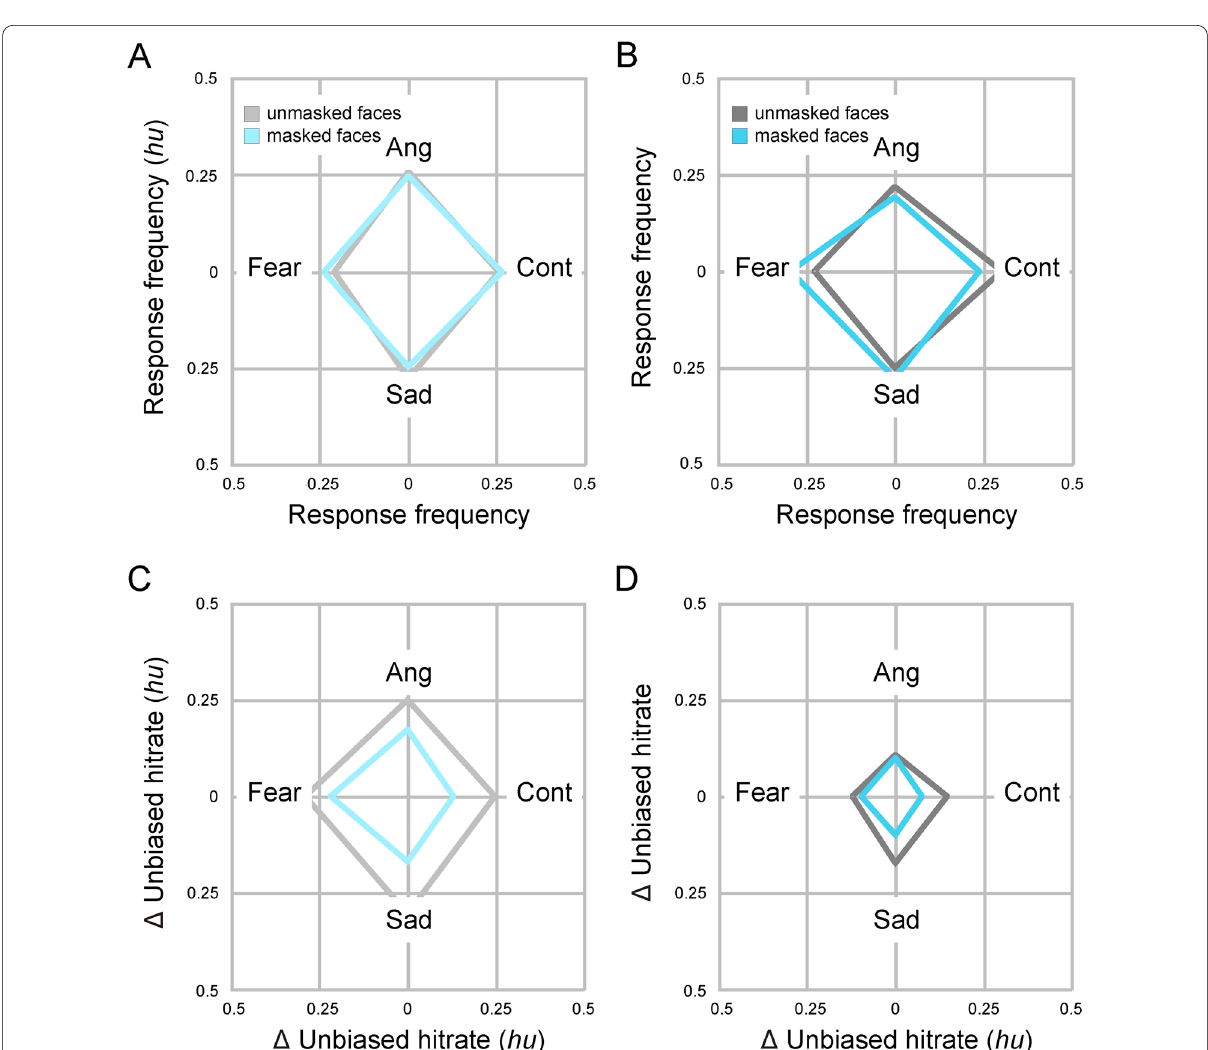
Fig. 3 Response frequencies and unbiased hit rates for each emotion. A, C young cohort; B, D old cohort. Unbiased hit rates are subtracted with chance